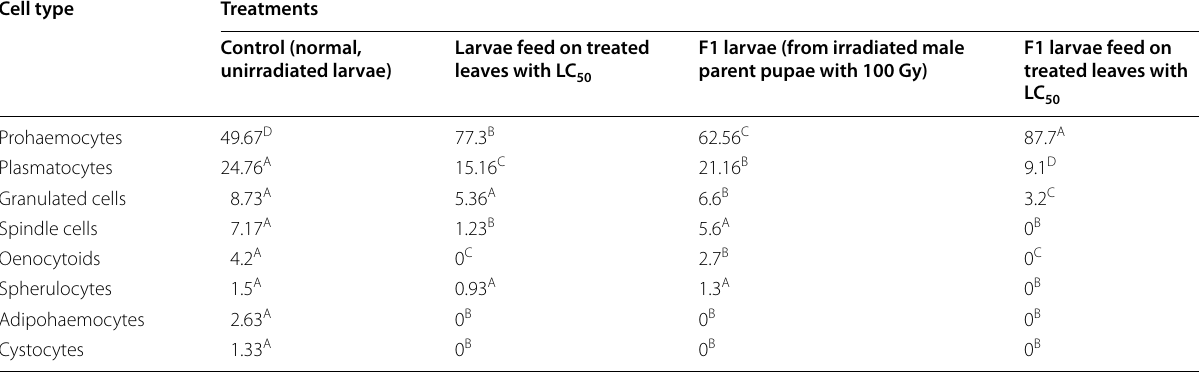
Values represent the mean of 3 replicates Means in the same columns that do not share a same letter are significantly different (Tukey Pairwise Comparisons) LC 50 of normal (unirradiated) and F1larvae are 20.49